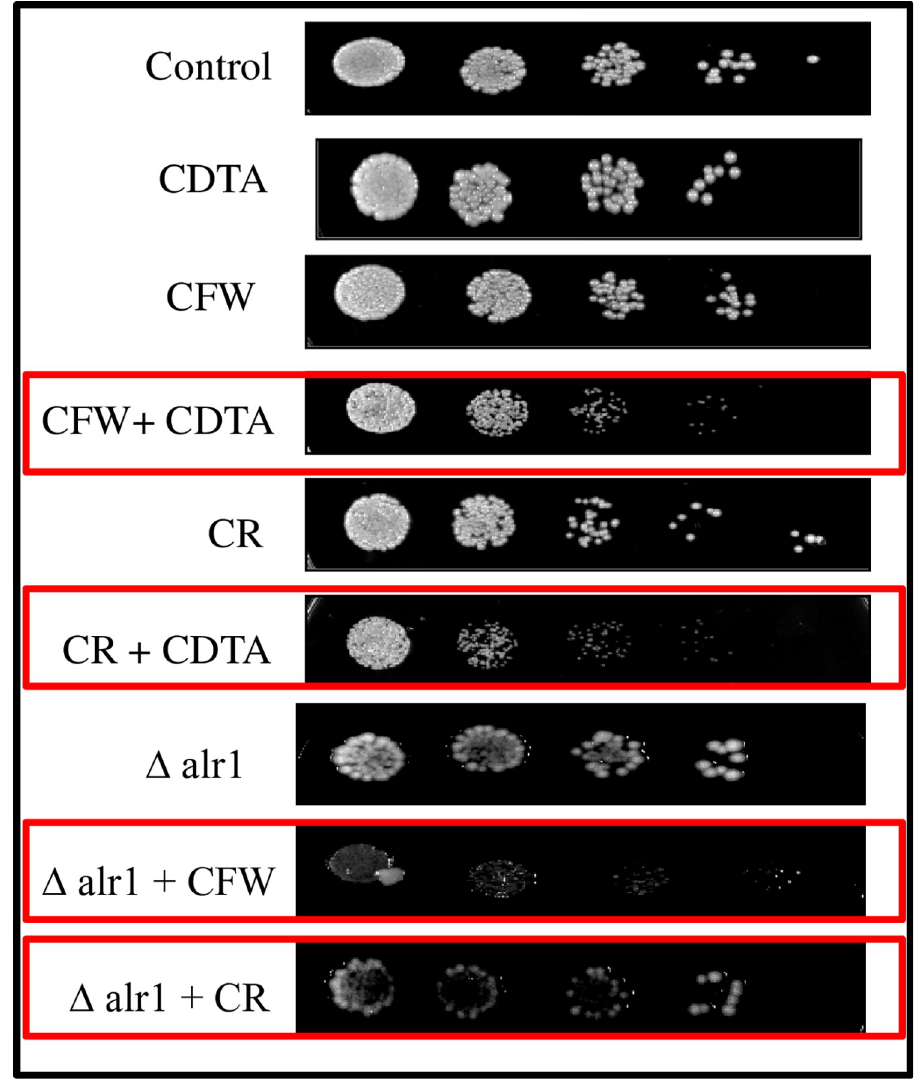
Fig 7. Sensitivity to cell wall perturbing agents under Mg deprivation. Spot assay of control, CDTA treated and Δ alr1 C . albicans in presence of CR (10 μ g/ml) and CFW (10 μ g/ml).